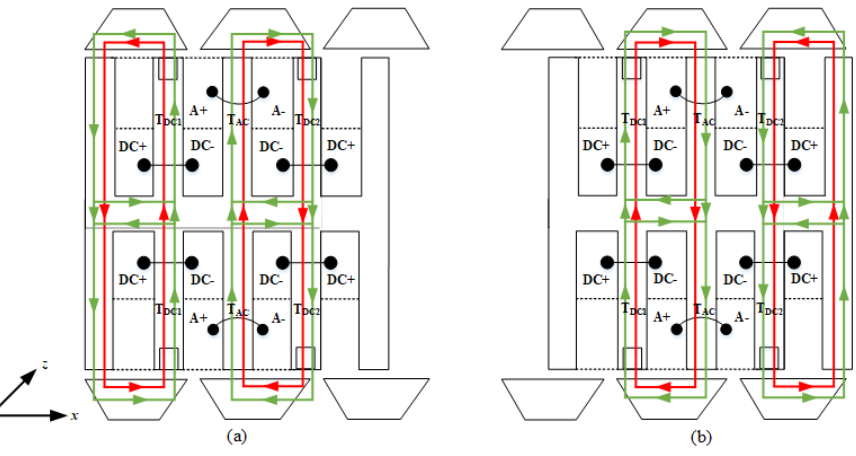
Figure 5. Magnetic circuit based working principle, ( a ) Positive max. flux linkage, and ( b ) Negative max. flux